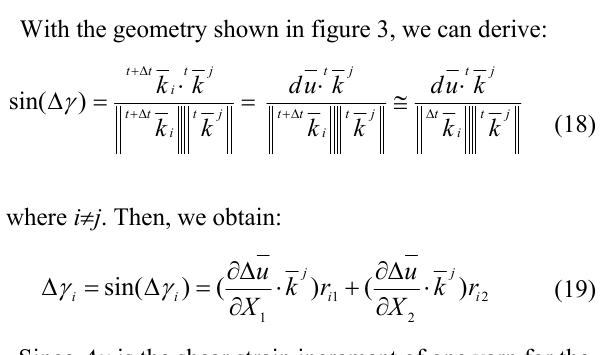
Initial form Final